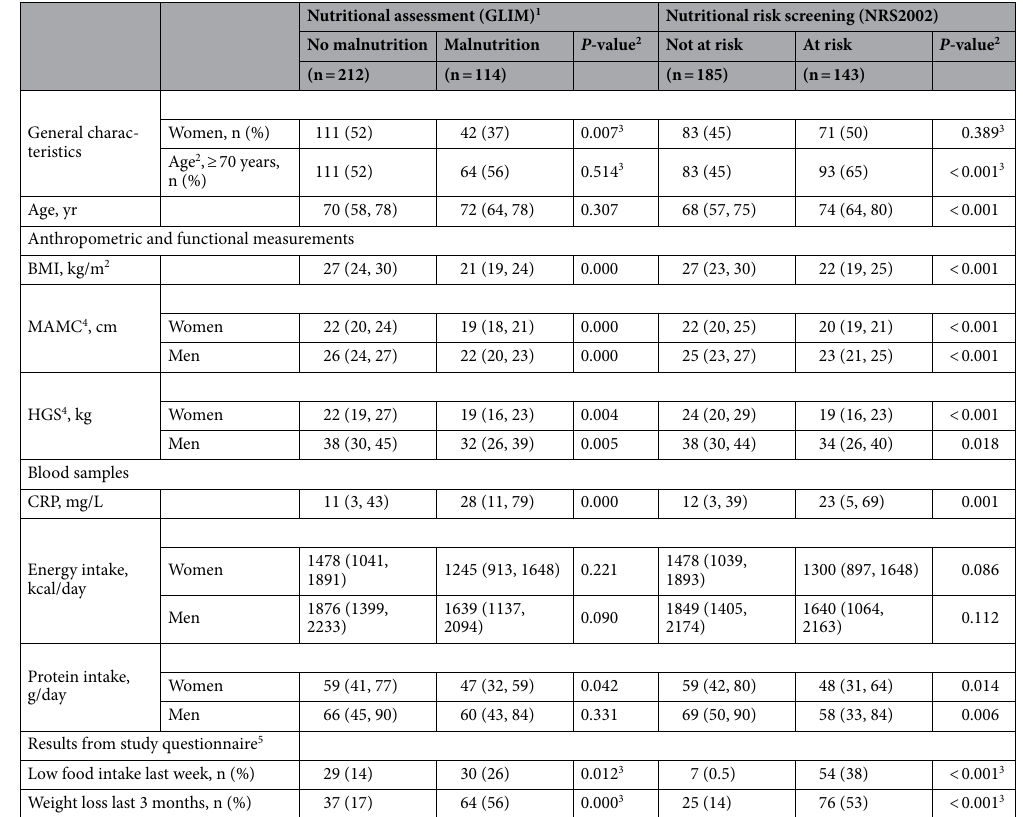
Table 3. Patient characteristics according to nutritional status assessed by the GLIM-criteria and according to the results from the study nutritional risk screening. Continuous variables are presented as medians (25th, 75th percentile) and categorical variables are reported as counts (%). BMI, Body mass index; CRP, C-reactive protein; HGS, handgrip strength; GLIM, Global Leadership Initiative on Malnutrition; MAMC, Mid-arm muscle circumference. 1 Two patients could not be assessed due to missing information. 2 P-value is calculated using Mann–Whitney U-test for nonparametric independent samples, significance level: p < 0.05. 3 P -value